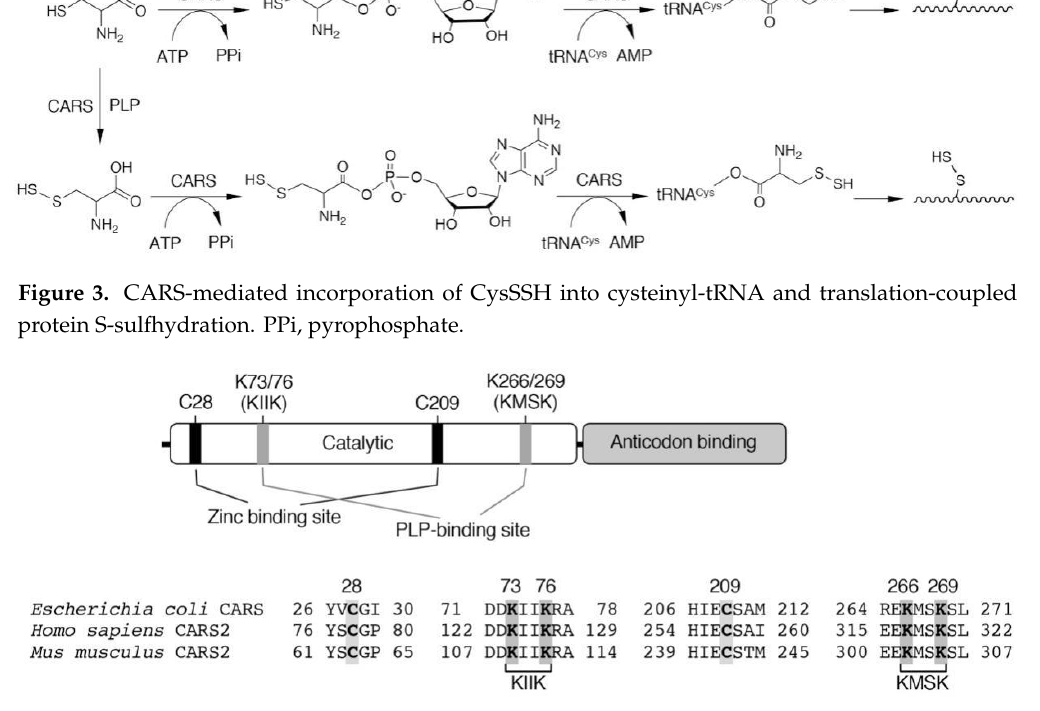
Figure 4. Domain structure and key amino acid residues involved in the aminoacylation and pyridoxal phosphate (PLP) binding of CARS.